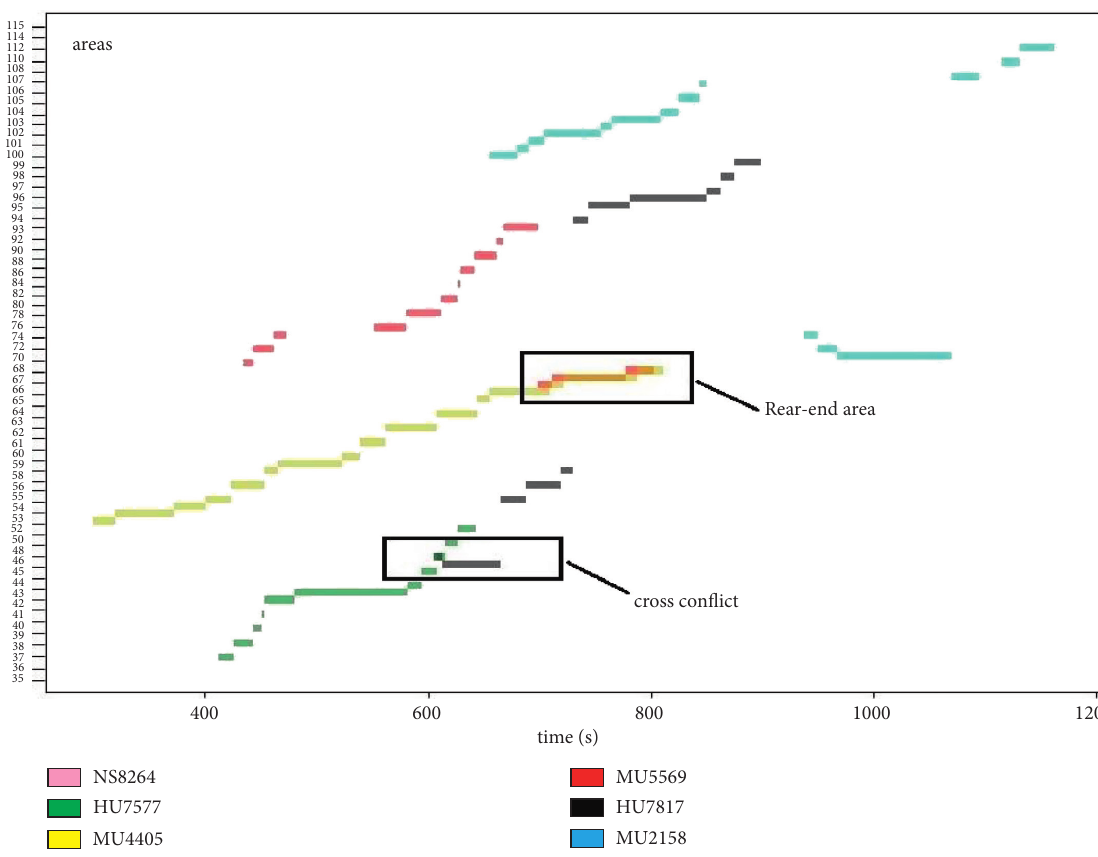
Figure 13: The area occupied the time window of the preselected route of the